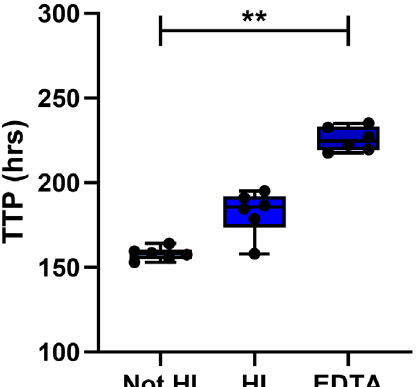
Figure 7. Effect of using heat inactivated serum or collecting blood in EDTA vacutainers. The effect of heat inactivating (HI) pooled human serum or of collecting blood in EDTA tubes was assessed using in-tube co-cultures for n=6 human PBMC. Points represent individuals with the mean of two replicate co-cultures, boxes indicate the median value with the interquartile range and whiskers indicate the minimum and maximum values. A Friedman test with Dunn’s correction for multiple comparisons was used where ** indicates a p-value of <0.01. TTP = MGIT time to positivity, HI = heat